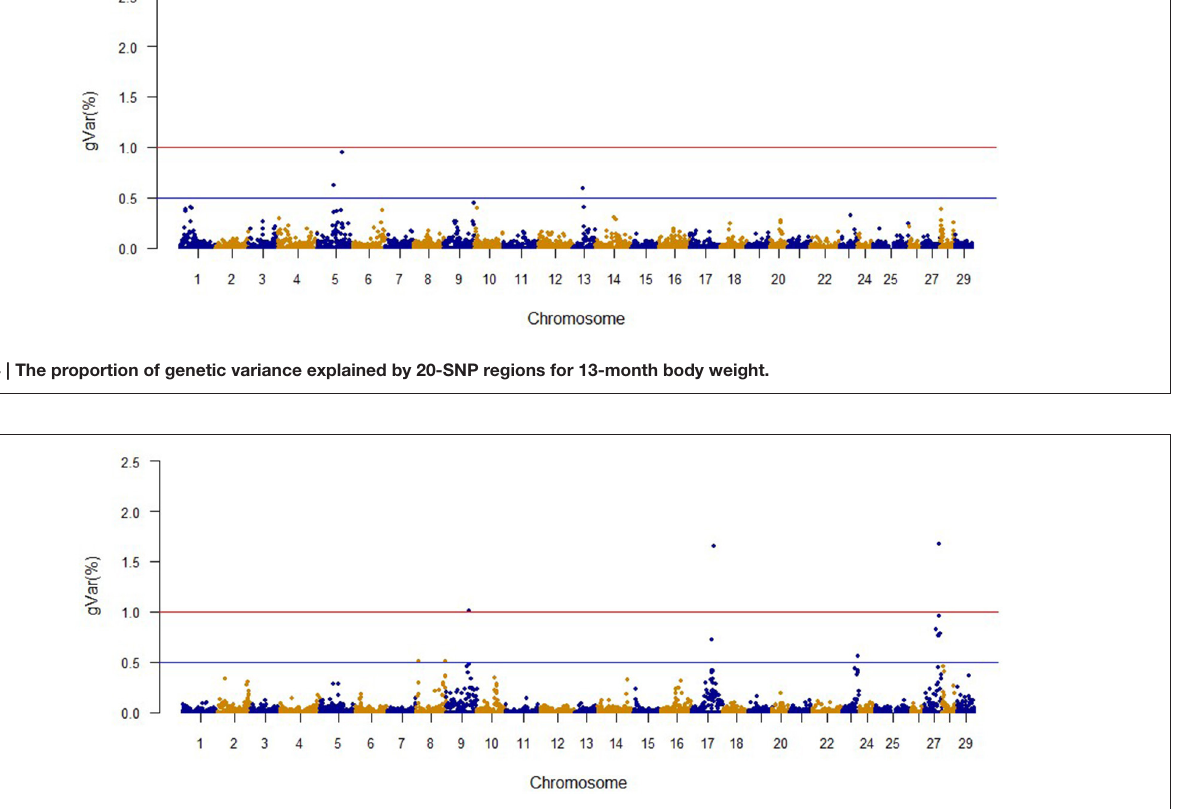
FIGURE 5 | The proportion of genetic variance explained by 20-SNP regions for carcass